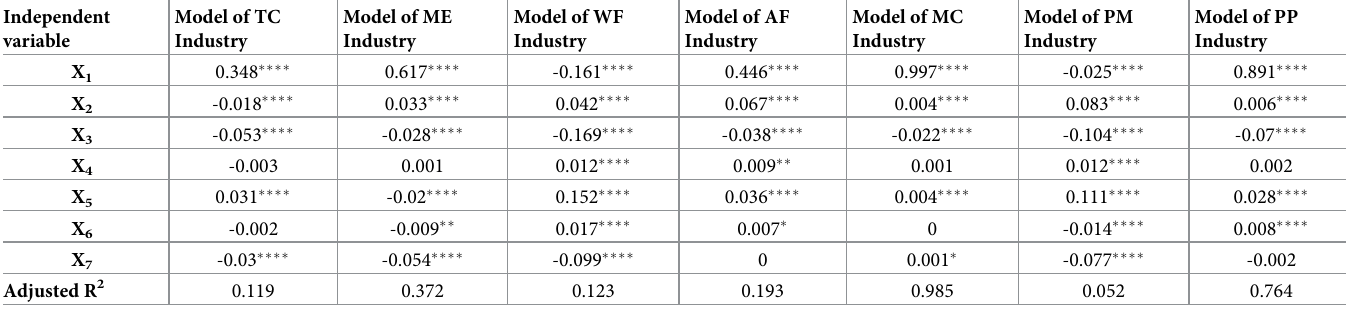
Table 2. Regression analysis of industry driving